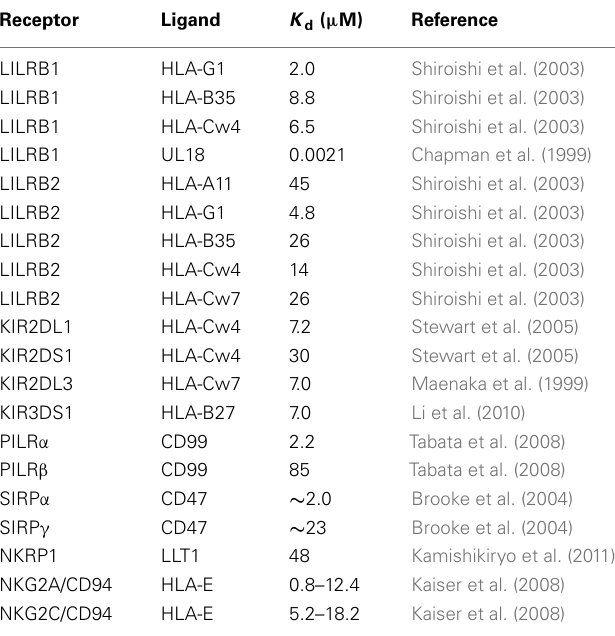
Table 2 | Examples of binding affinities of receptor-ligand